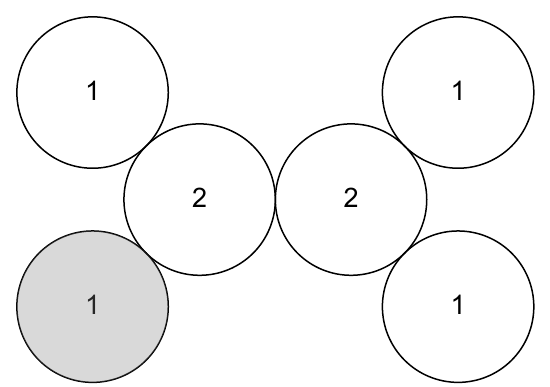
Figure 1. Fiber at generic points along a codimension-one locus supporting an so (10) algebra. The shaded curve corresponds to the affine node of the ˆ D each circle denote the multiplicity of the